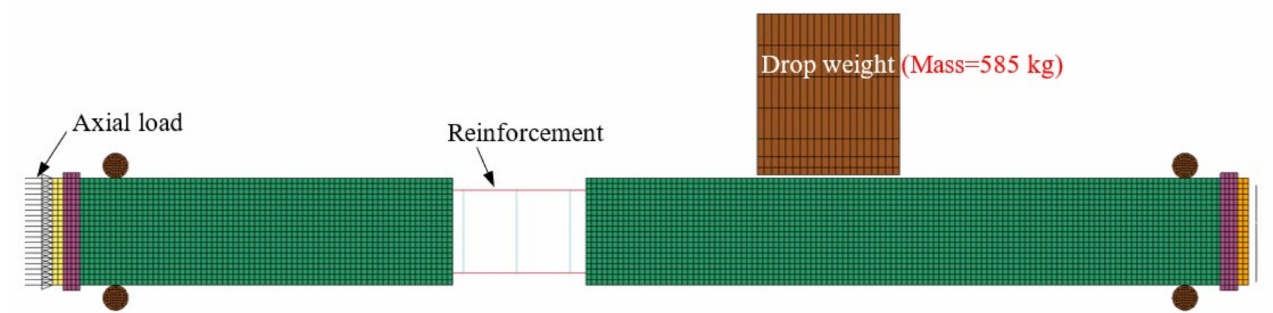
Figure 3. Numerical model of the column under impact